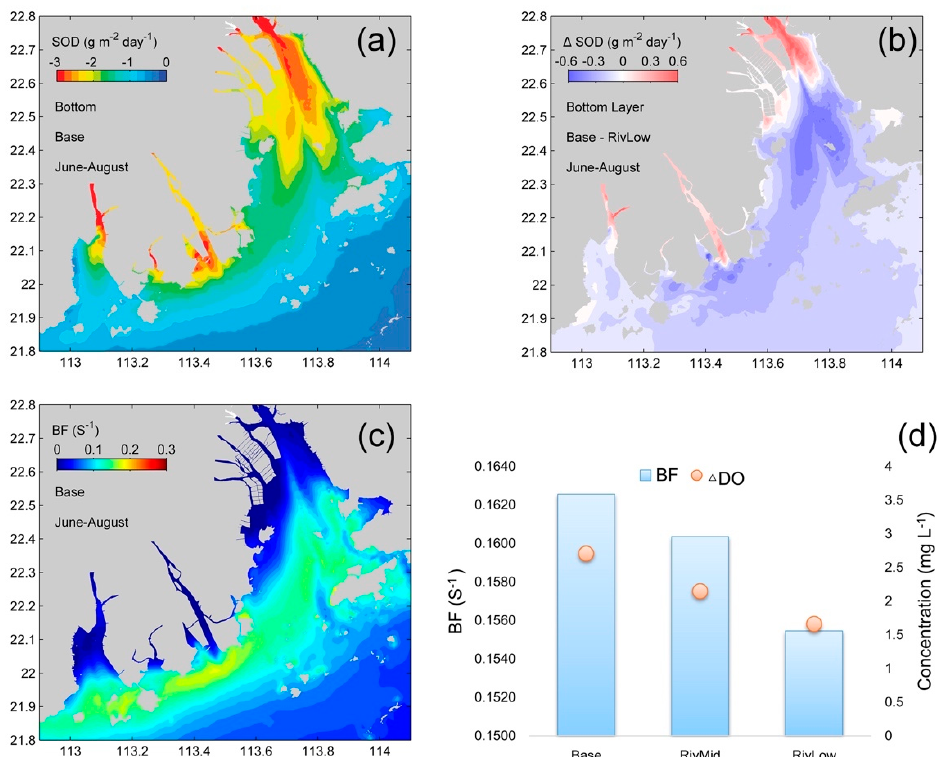
Figure 10. ( a ) Spatial distributions of the SOD in summer (June–August); ( b ) deviation in the SOD of the river discharge variation run from the base model run (base—RivLow); ( c ) the Brunt–Väisälä buoyancy frequency (BF) of the base run; and ( d ) BF and DO concentration difference between the surface and bottom of the river run in the Modaomen hypoxic zone.